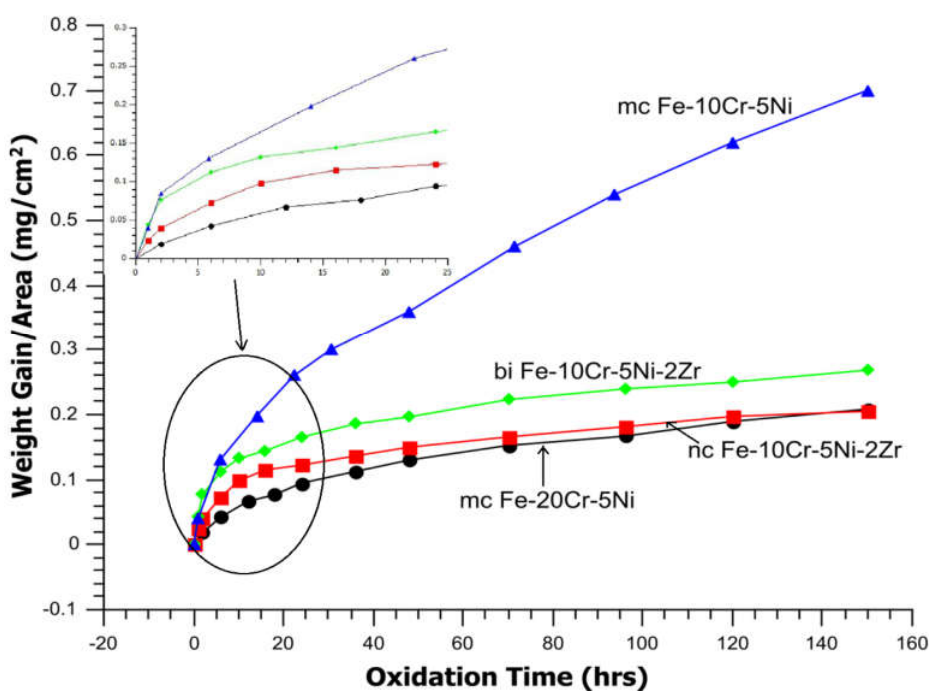
Figure 8. Oxidation kinetics of the nanocrystalline (nc), bimodal (bi), and microcrystalline (mc) alloys at 550 °C. The inset shows the difference in the oxidation kinetics trend during the initial stages of oxidation. ([33], reproduced with copyright clearance).